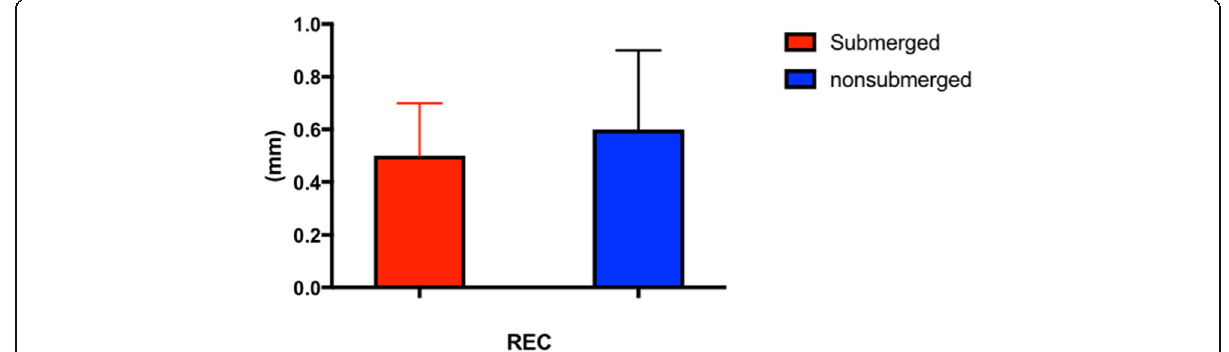
Fig. 6 Mean values of gingival recession (REC) between the two groups at the end of follow-up period (3-year). ANOVA test